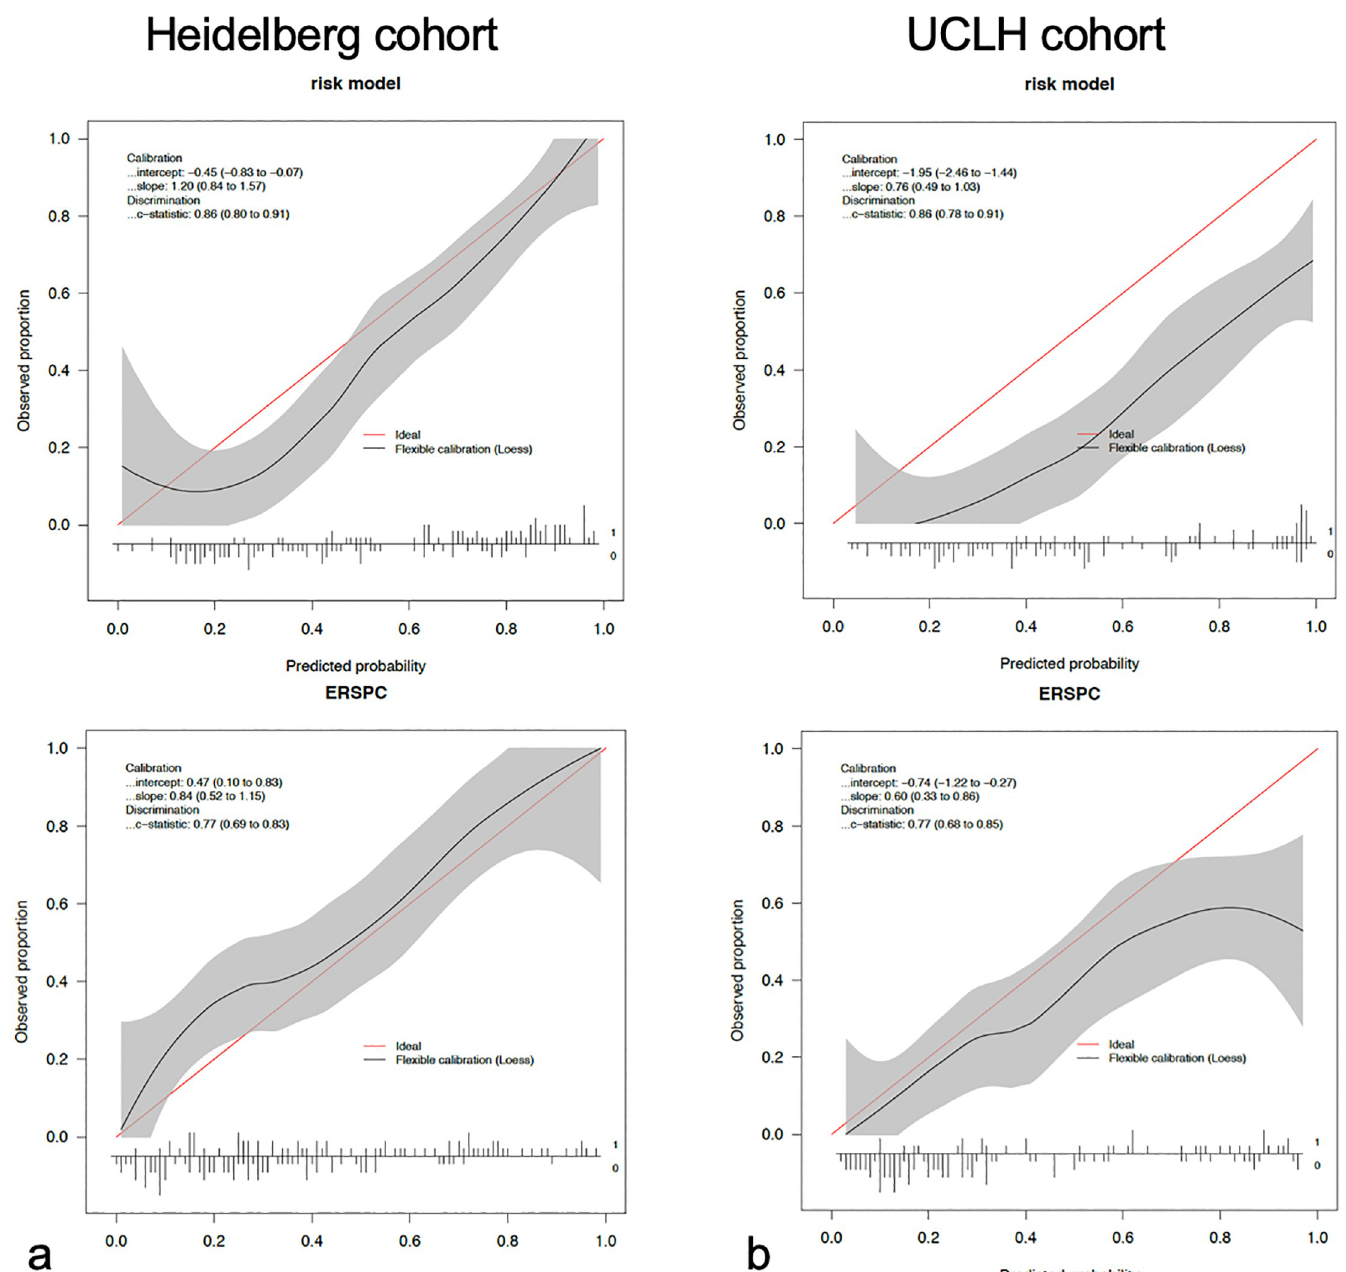
Fig 2. Calibration plots for the risk model and ERSPC-RC3 to predict sPC. a) Calibration plots for the Heidelberg validation cohort, b) Calibration plots for the UCLH validation cohort.